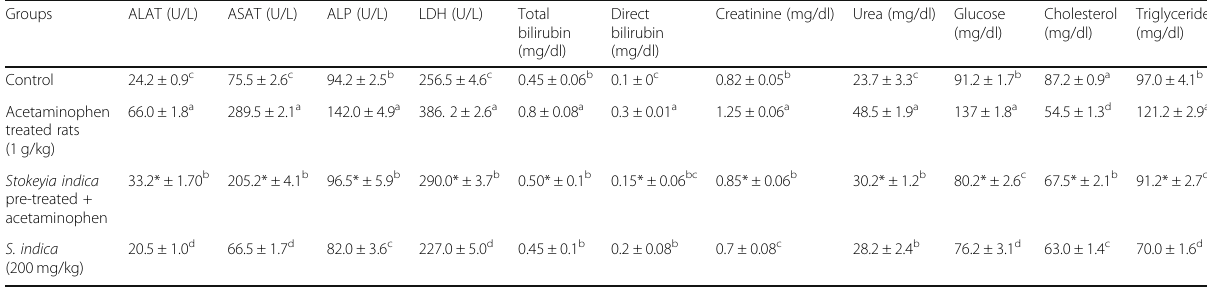
Table 2 Effect of Stokeyia indica ethanol extract on serum biochemical parameters in normal and acetaminophen intoxicated rats